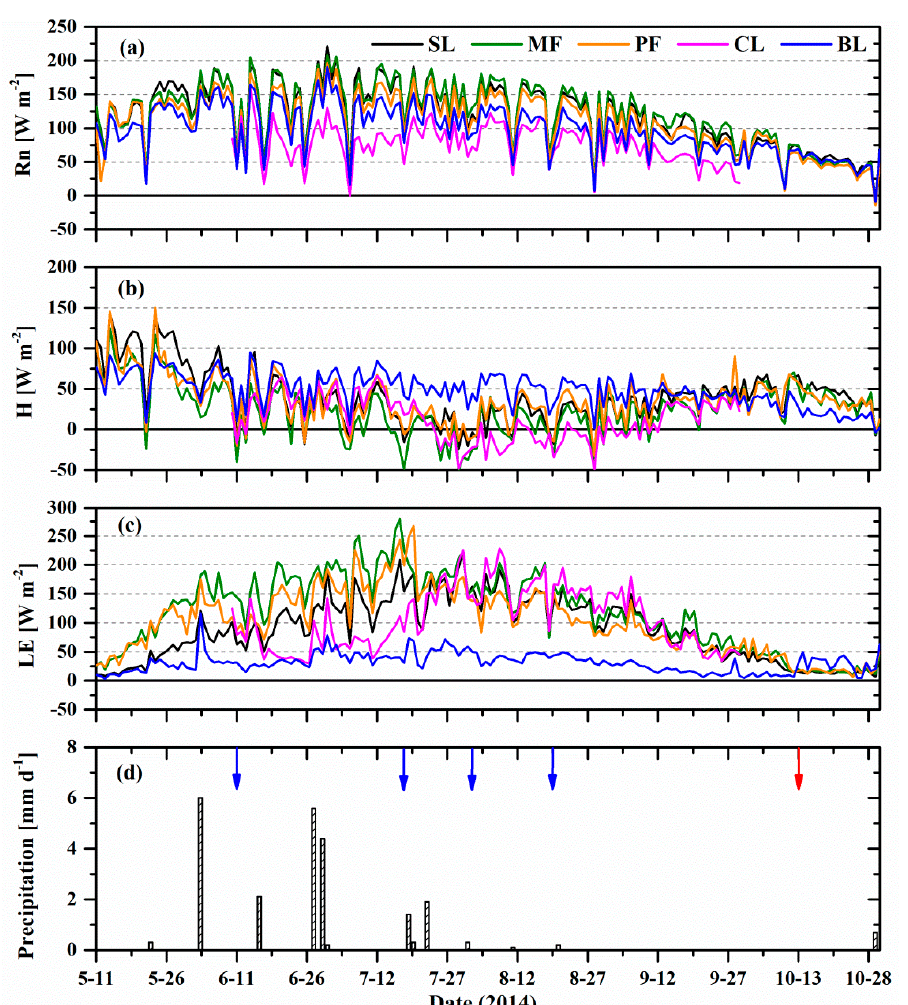
Figure 6. Temporal variation in daily (24-h) averages of ( a ) net radiation, ( b ) sensible heat flux, ( c ) latent heat flux, and ( d ) daily (24-h) cumulative precipitation. In ( d ) the blue arrows represent irrigations with groundwater over cropland site during the growing season in 2014; the red arrow indicates flood irrigation over the cropland with the water from the Heihe River. SL is T. chinensis shrubland, MF is mixed forest of P. euphratica and T. chinensis , PF is sparse P. euphratica forest with associated T. chinensis shrubland, CL is cropland, and BL is barren-land. Table 4. Ratios of monthly H and LE to R n (8:30–18:30 BST; Beijing Standard Time) at the five sites during the growing season of May–October in 2014.